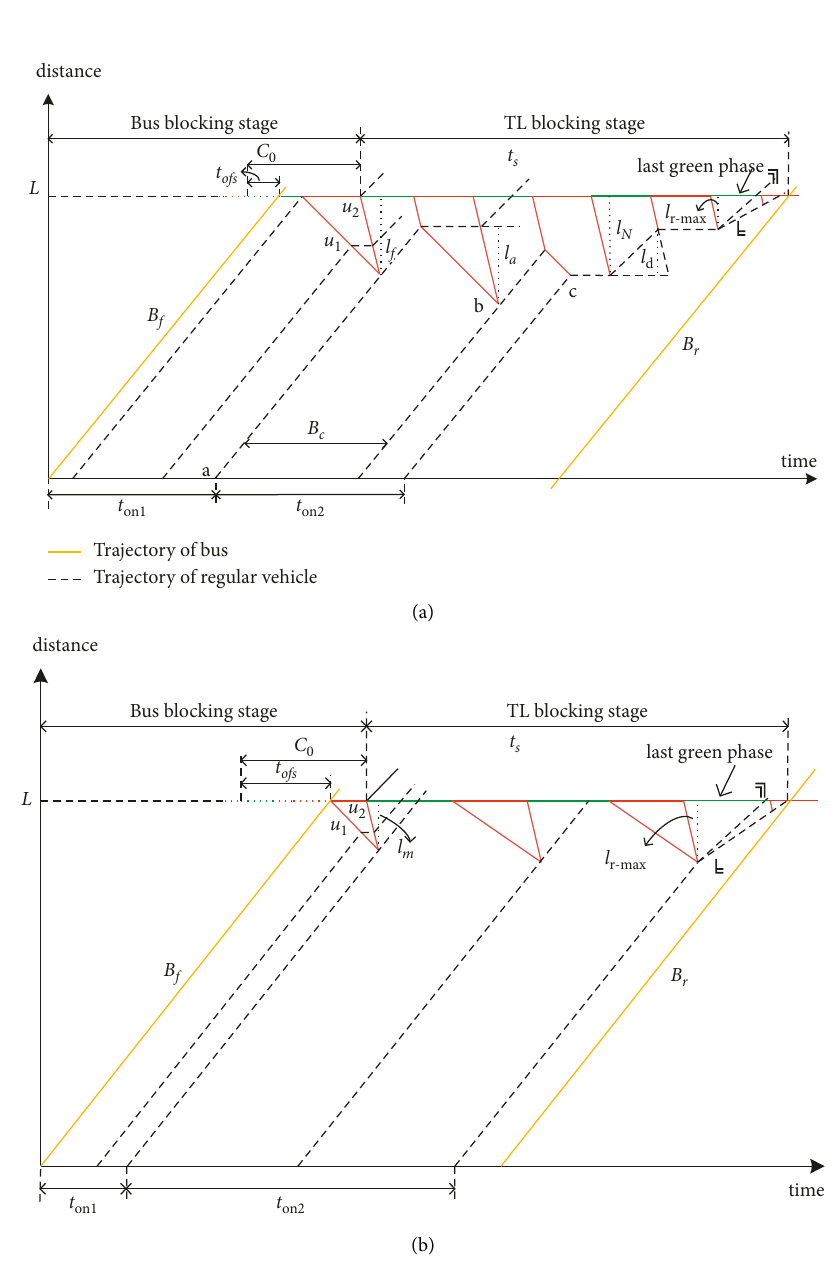
Figure 2: Time-space diagram of two possible evolution processes of lane-borrowing traffic flow with different arrival signals and different traffic flow saturations in the road section. (a) Evolution process of two stages with green arrival signal (0 traffic. (b) Evolution process of two stages with red arrival signal ( λ c